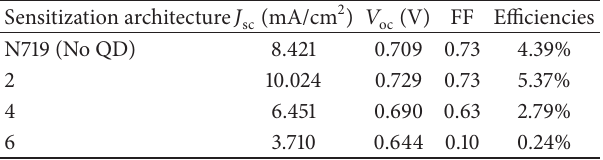
Table 2: Parameters of DSSCs constructed with different sensitiza- tion